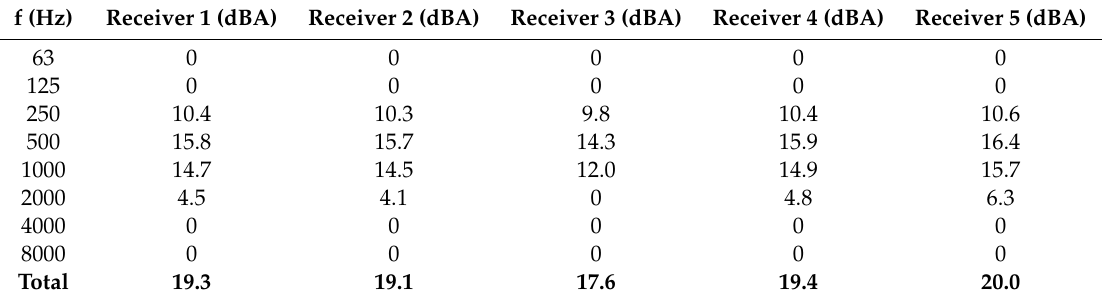
Table A1. Octave-band SPL for each receiver at the Cape Busto location using the ISO standard.